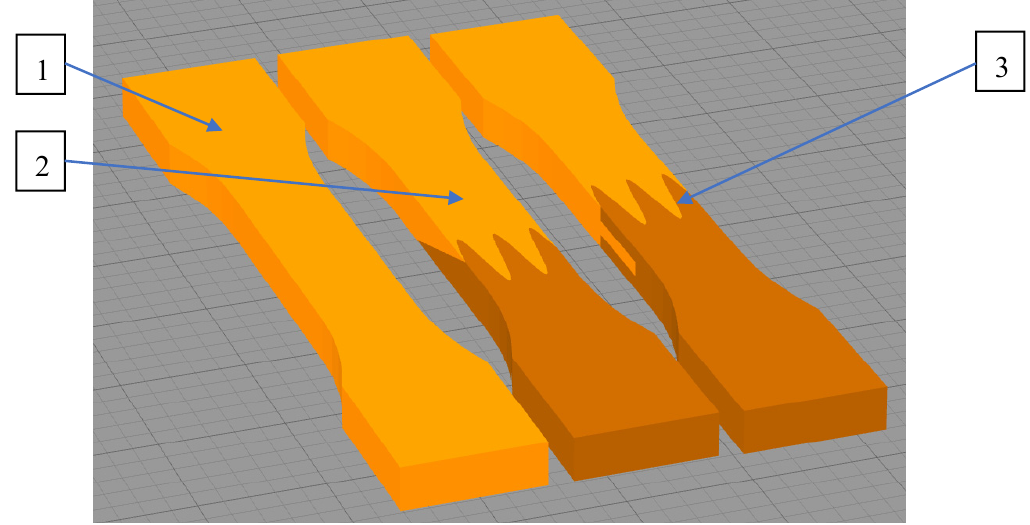
Figure 3. Designed samples: 1—the monolithic reference sample; 2—the overlap connection, 3—the pleated connection.